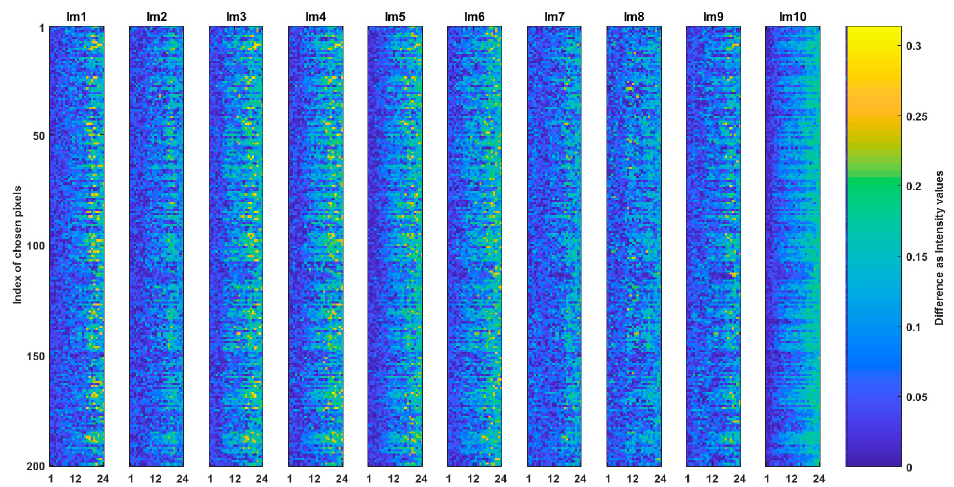
Figure 11. Comparison of Hex CEsq and Hex _ E p .